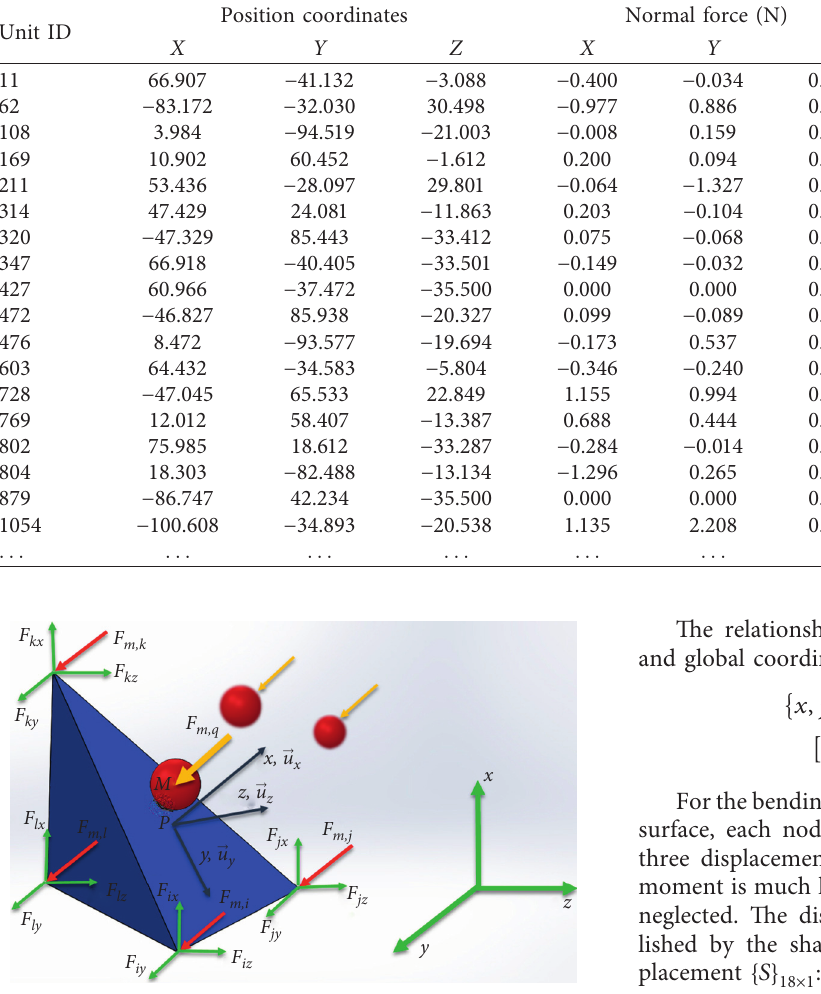
Figure 8: Contact force conversion diagram of tetrahedral